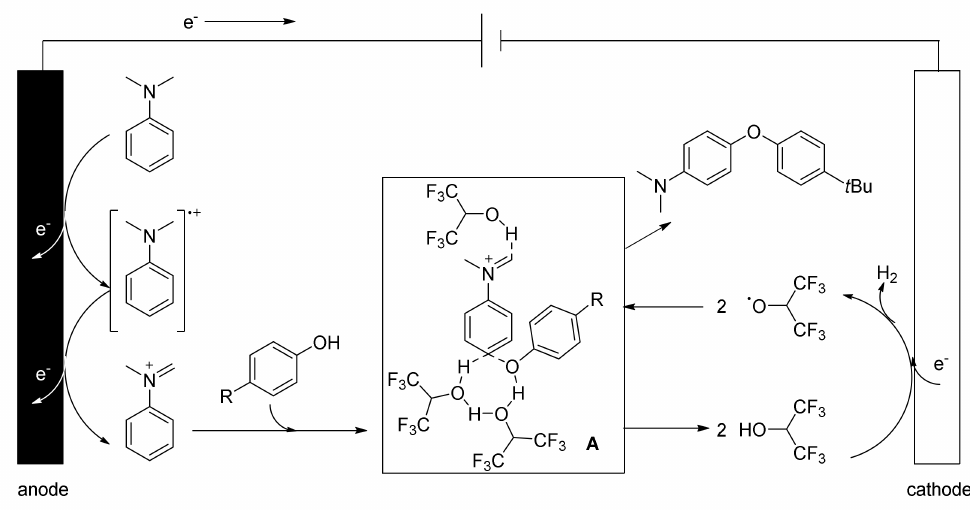
Figure 8. Proposed mechanism for C(sp 2 )-O